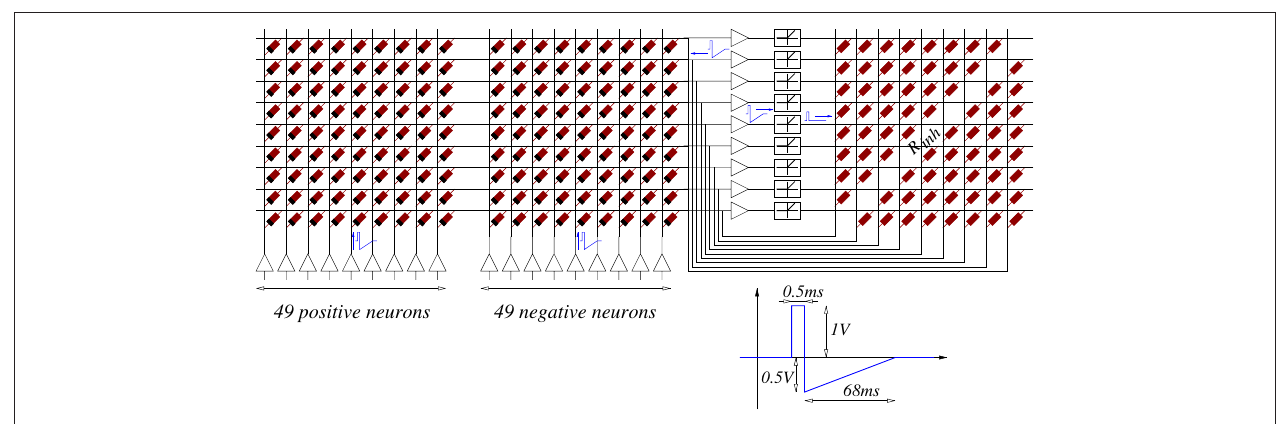
Figure 26 | Circuit Topology and Spike Shape used for the Spectre electrical circuit simulation of the simplified V1 network.